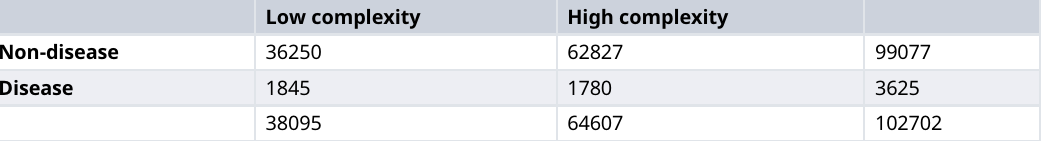
Table 1. Contingency table between disease association in gene transcripts presenting compositionally biased regions versus gene transcripts without any detectable compositional